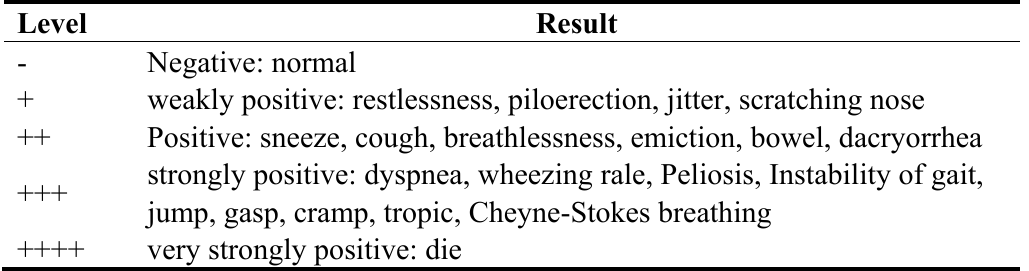
Table 3. The evaluation criterion of